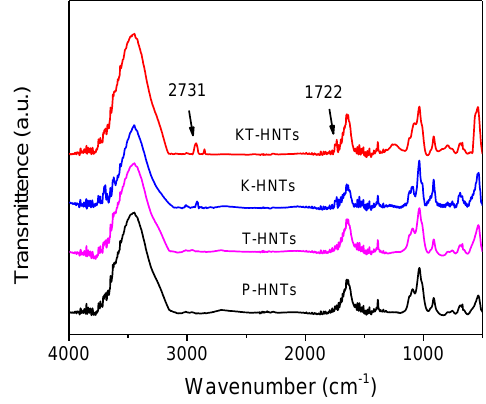
Figure 2. FTIR spectra of pristine HNTs and modified HNTs, P-HNTs, T-HNTs, K-HNTs, and KT-